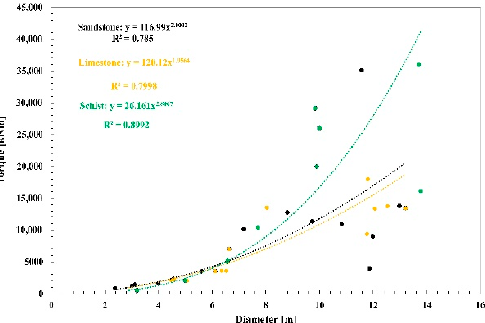
Figure 15. Correlation between the diameter and the torque due to the excavation in sandstone, limestone and schist by single shield TBMs.